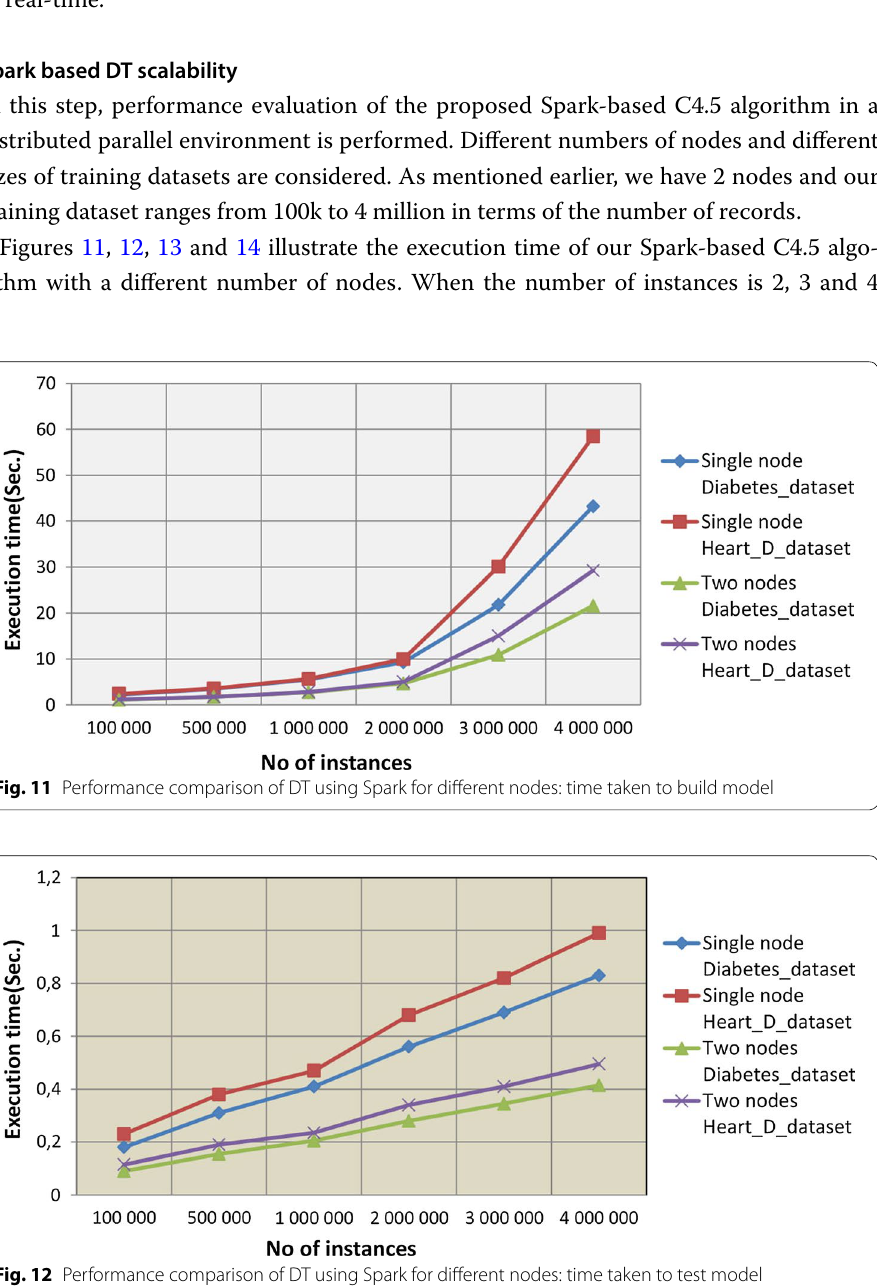
Fig. 12 Performance comparison of DT using Spark for different nodes: time taken to test